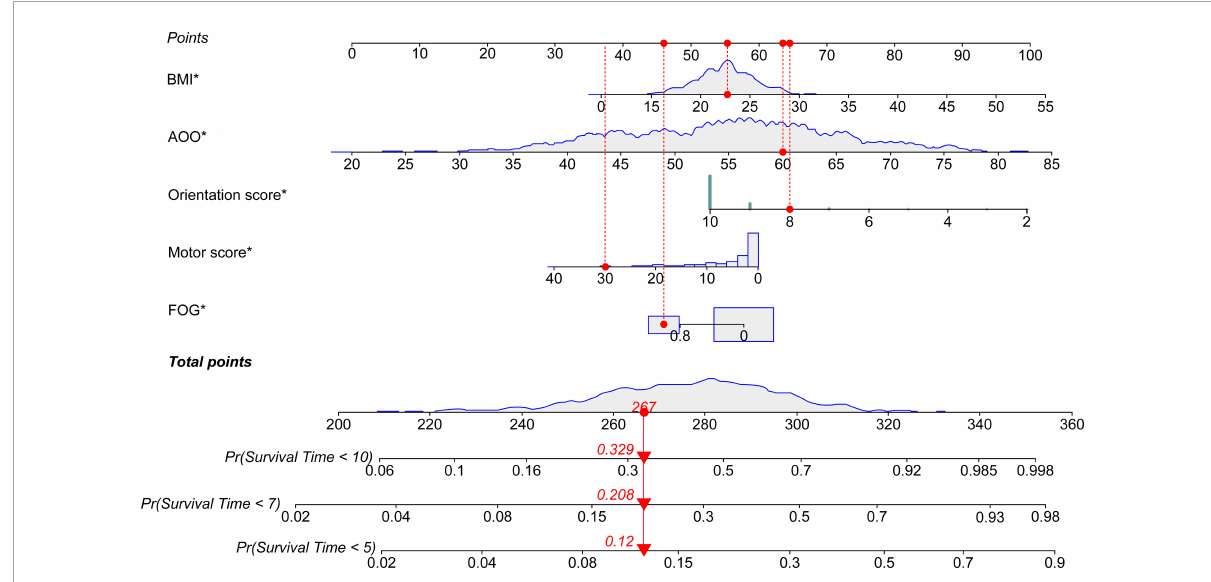
FIGURE3 Nomogram for survival time with five variables. The nomogram showed that each factor has a score, and the total score is the sum of the scores of each factor, corresponding to the probability of EDS occurring at different survival times. Survival Time: the time from the diagnosis of PD to the end of follow-up, namely, the course of the disease at baseline plus 1 year. PD, Parkinson’s disease; EDS, excessive daytime sleepiness; BMI, body mass index; AOO, age of onset; FOG, freezing of gait. * P <